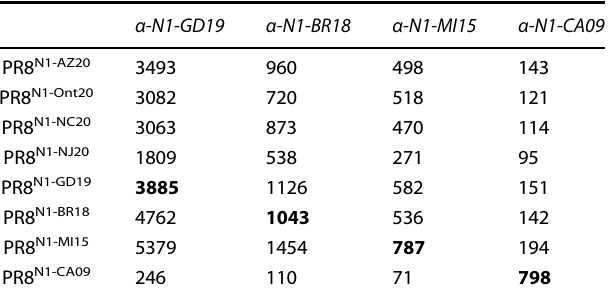
Table 2. NAI titres for the indicated N1 reassortant viruses and antisera.